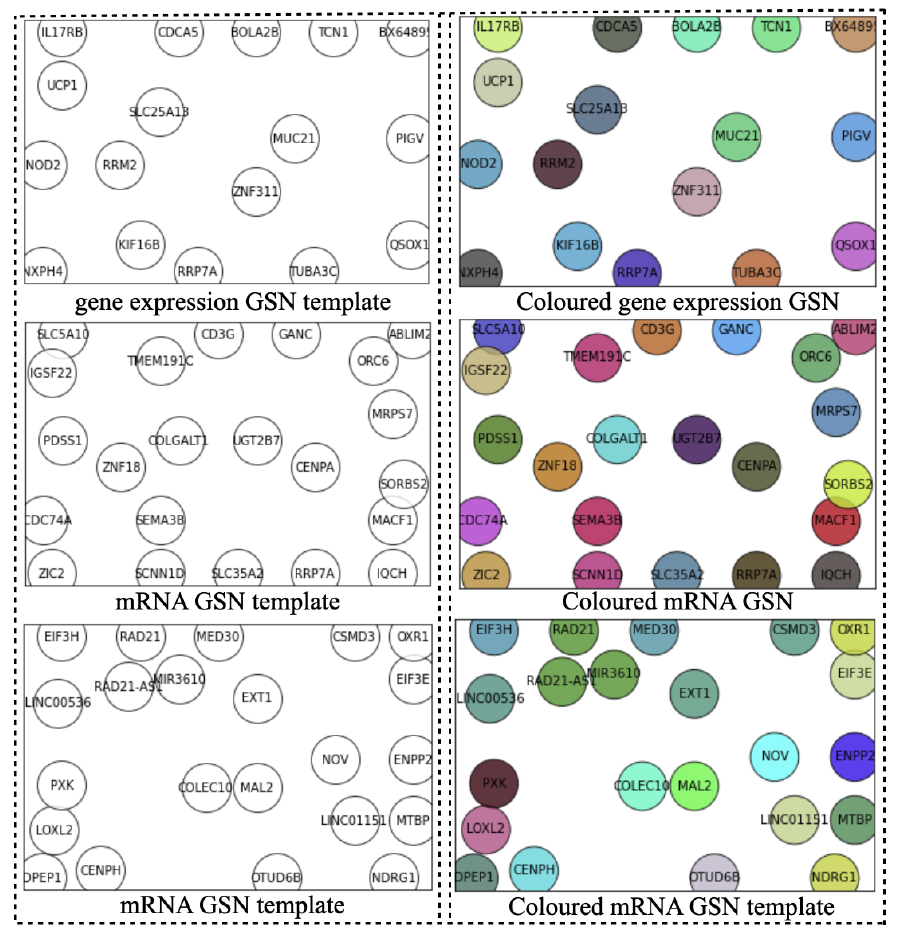
Figure 3. Templates of three omics datasets embedded by SOM